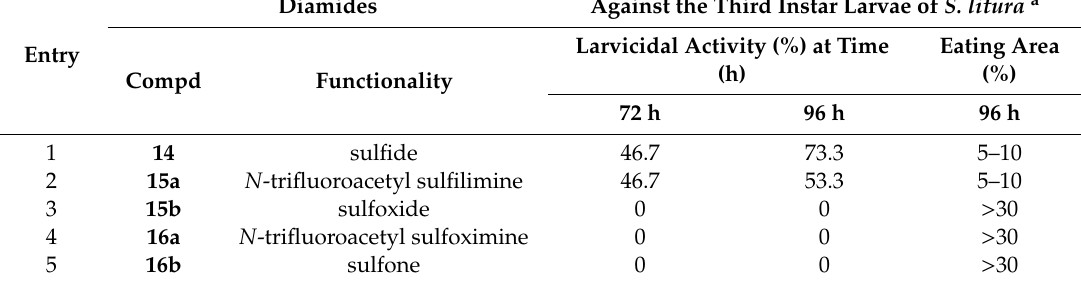
Table 2. Insecticidal activities of sulfide- and N -trifluoroacetyl sulfilimine-based diamide 14 and 15a against the third instar larvae of Spodoptera litura.